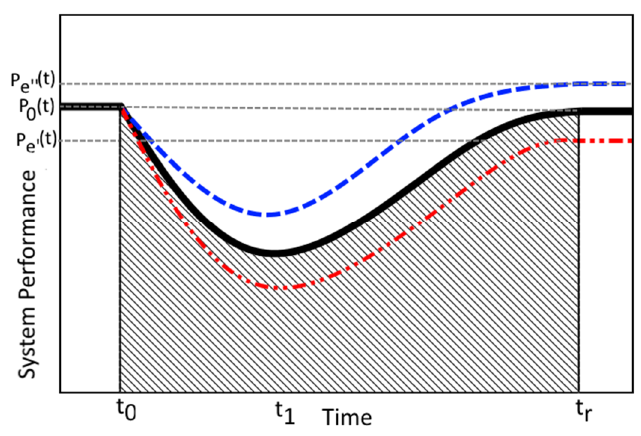
Figure 4. Illustration of transformation of system performance into resilience.